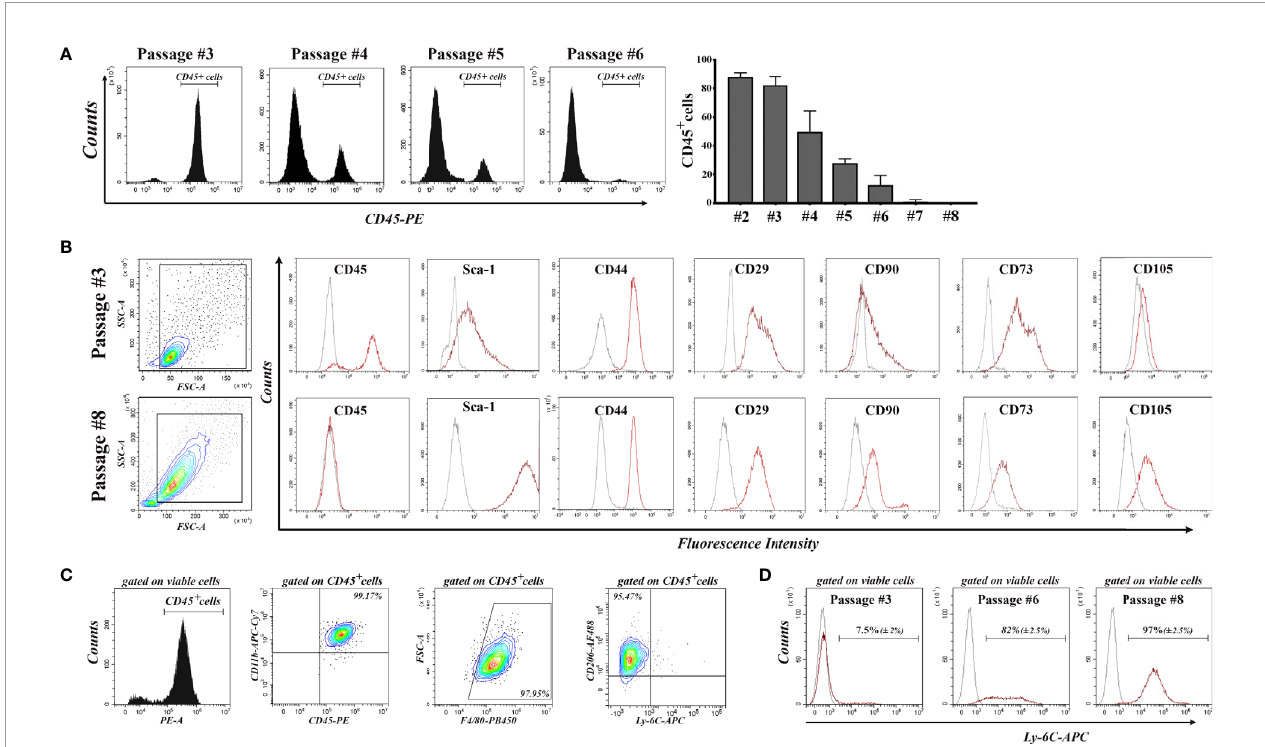
FIGURE 1 | Flow-cytometry characterization of cells emerged from mouse bone marrow aspirate during serial passages until total depletion of CD45 pos cells. (A) The decrease in the percentage of CD45 pos cells with each passage. Note that the culture becomes completely depleted of CD45 pos cells after passage 6. Data are mean +/- S.D of at least 6 experiments. (B) Comparative analysis of the expression of cell markers in culture at passages 3 and 8. Note the presence of MSC markers (except CD105) on the cells at passage 3, when most of them are CD45 pos cells. At passage 8, the culture contained no CD45 pos cells, and cells are CD105 pos . (C) Characterization of hematopoietic cells at passage 3. Note that all CD45 pos cells (around 80% of total viable cells in culture) are CD11b pos /F4-80 pos / CD206 pos /Ly-6C neg , being therefore asserted as anti-in fl ammatory cells. At least 3 different batches were analyzed and the results were similar. (D) Expression of